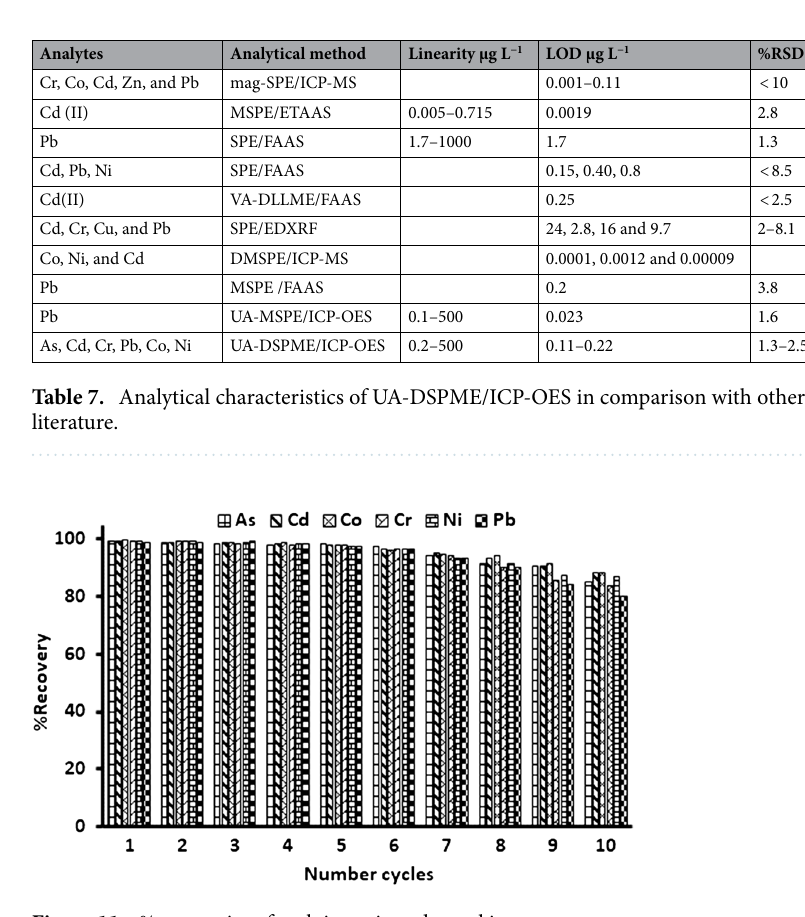
Figure 11. % recoveries of each investigated metal